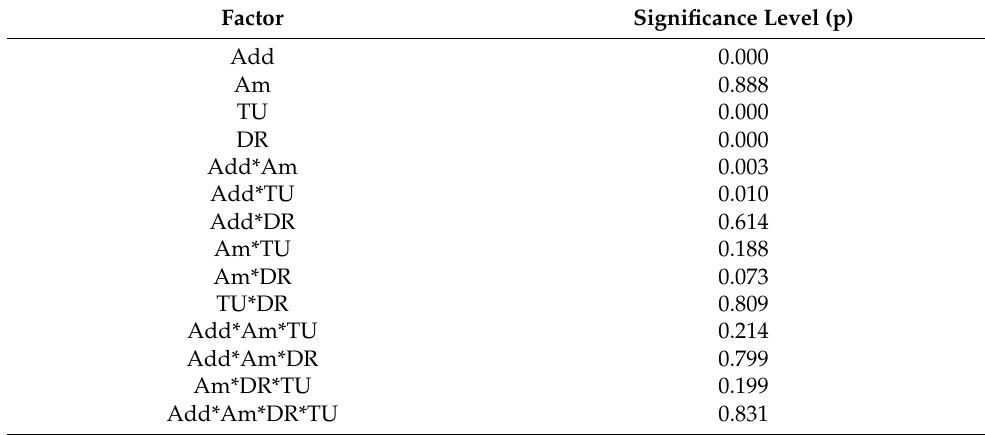
Figure 10. Pareto chart representing the effective strength and cumulative frequency of the factors and their interactions on the degree of crystallinity (X c ). DR = draw ratio, TU = take-up velocity, Add = nucleating agent, and Am = amount of nucleating agent. Table 6. Significance level (p) of factors and their interactions corresponding to Figure 10.